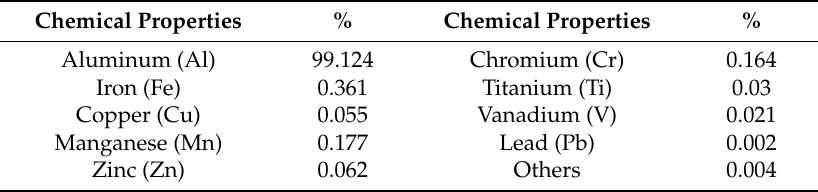
Table 3. Chemical properties of the aluminum used in the reference product.